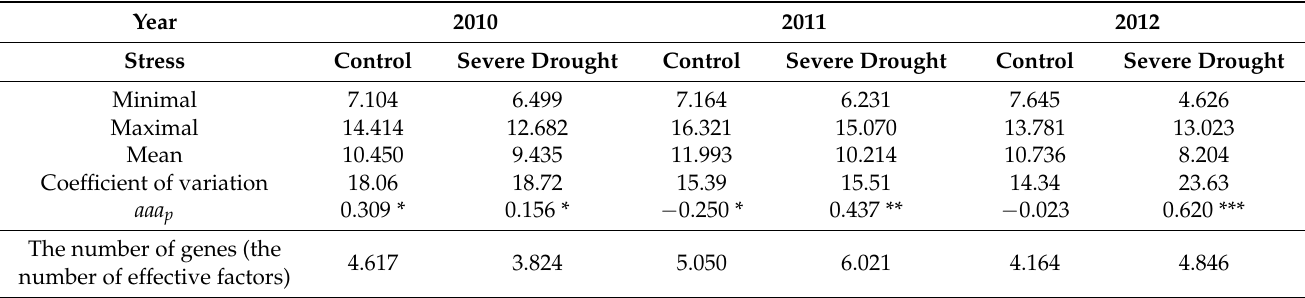
Minimal and maximal values of average for lines, means for all doubled hap- loid lines for total phenolic content, coefficient of variation, phenotypic estimates of the total additive × additive × additive effect ( aaa p ) and the number of genes (the number of effective